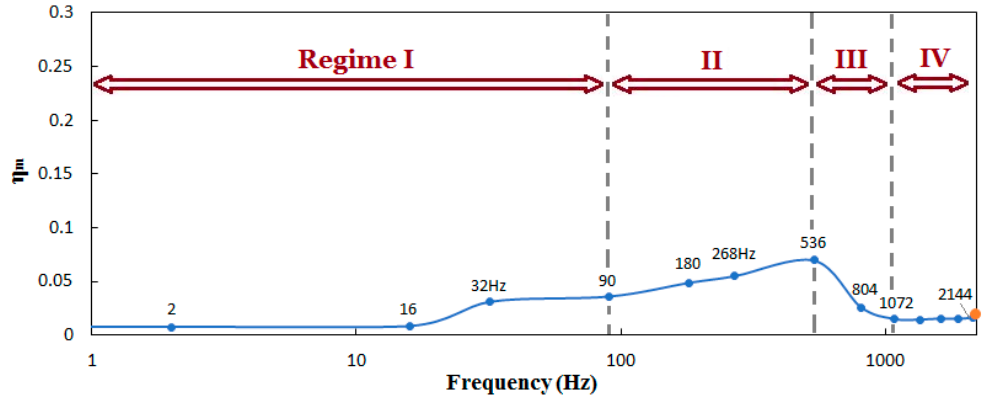
Figure 33. The variation of the spanwise-averaged effectiveness in terms of frequency (Hz) at X/D = 7 for M = 1.0 obtained by the FLUENT, LES, Smagorinsky–Lilly model. The orange color point is the result for the multi-frequency unsteady flow. It represents the spanwise-averaged film cooling effectiveness when Equations (28) and (29) are used instead of individual frequencies.